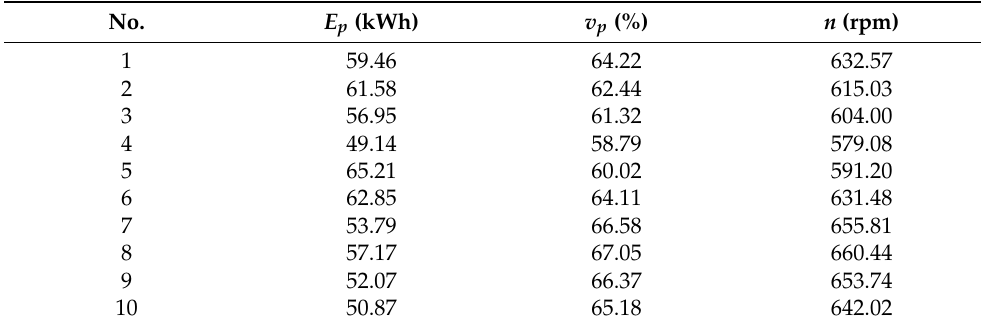
Table 4. Energy consumption and revolutions of the conveyor motor divided into individual tests [22].